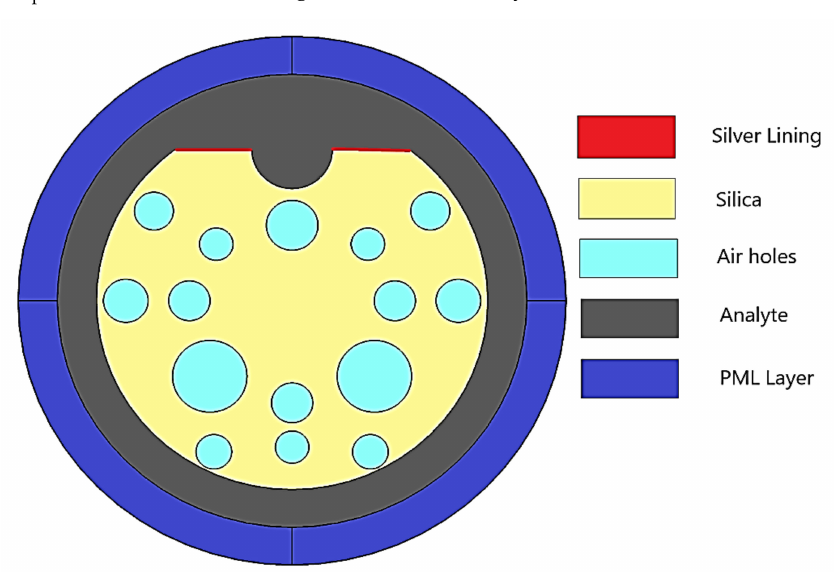
Figure 10. Graphical representation of the SPR based sensor structure.